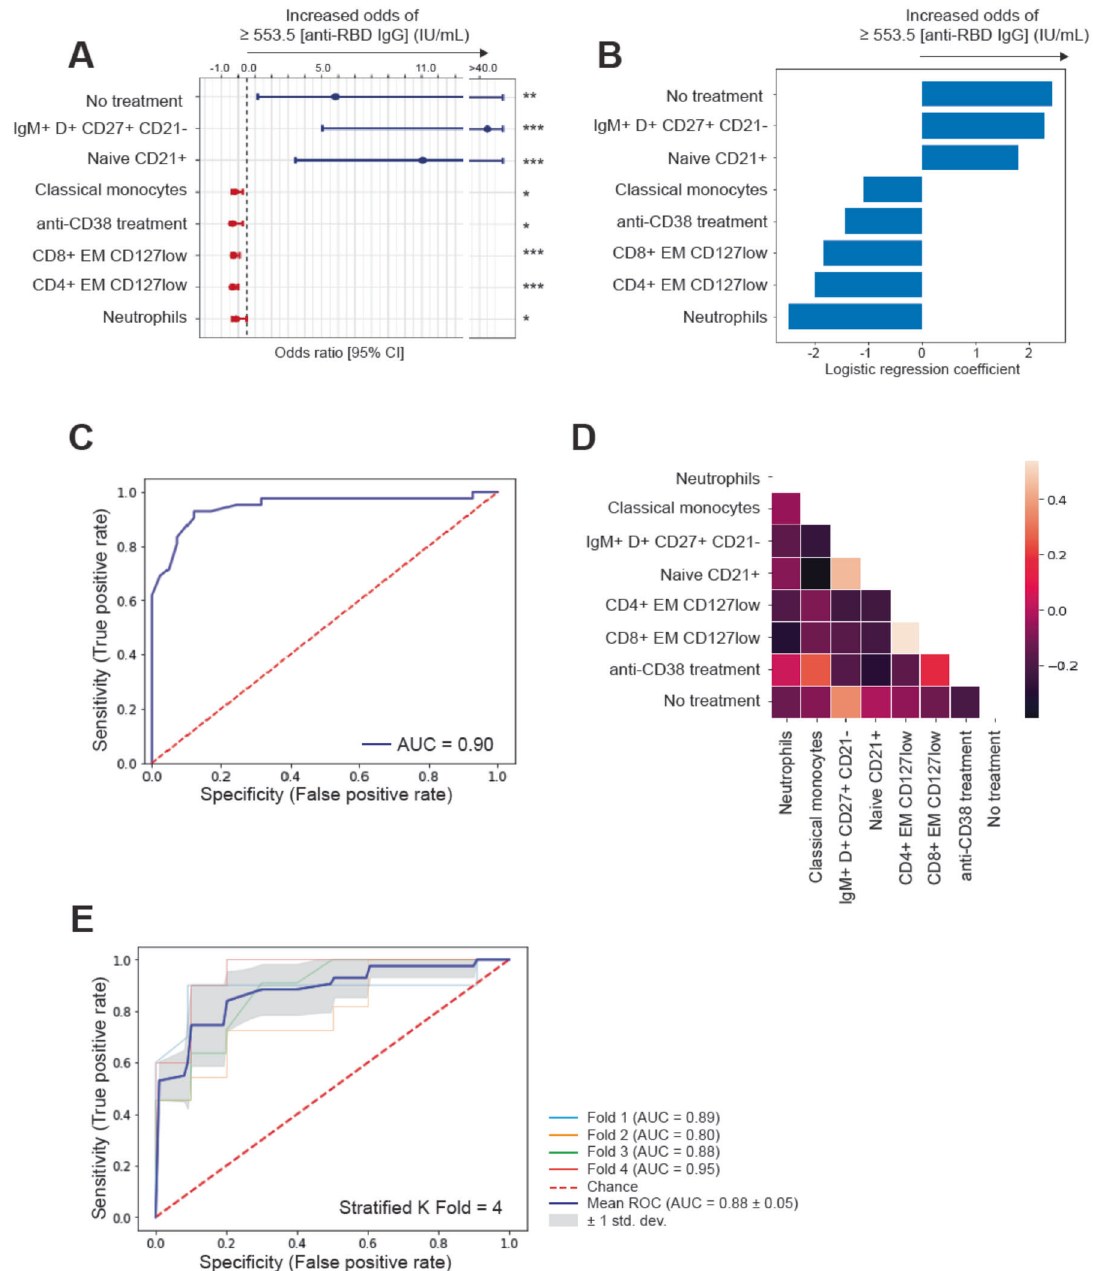
Fig. 6 Immune biomarkers of immunogenicity. A Odds ratio univariate analysis with 95% con fi dence intervals (CI) of variables included in the logistic regression model. B Logistic regression coef fi cients with treatment-related features as well as immune biomarkers associated with generation of ≥ 553.5 IU/mL of IgG antibodies against the receptor-binding domain (RBD) of the S-glycoprotein. C Area under the curve (AUC) of prediction probabilities of patients ’ dataset. D Correlation matrix of immune and treatment-related features. E Fourfold cross-validation of AUC of prediction probabilities of patients ’ results identify six immune biomarkers predictive of weak immunogenicity, which are independent of patient ’ demographics and clinical characteristics.